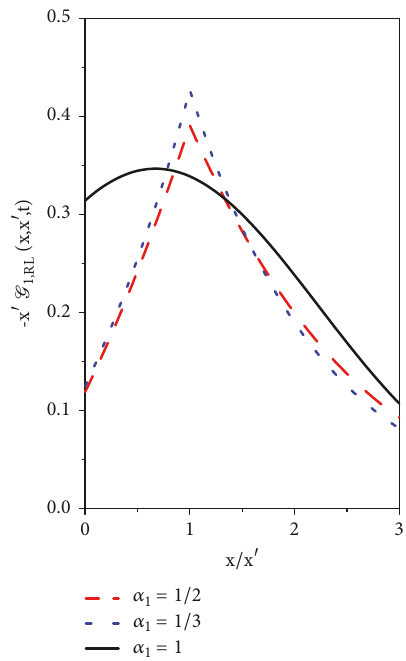
Figure 2: This figure illustrates the behavior of (27) by consid- ering different values of 𝛼 1 . We consider, for simplicity, 𝜏 1,𝑅𝐿 = (𝑥 󸀠2 / K ) 1/𝛼 1 , 𝑘𝜏 /𝑥 󸀠 = 1 , and 𝑡 = 𝜏 1 1,𝑅𝐿 1,𝑅𝐿 , in arbitrary unities.